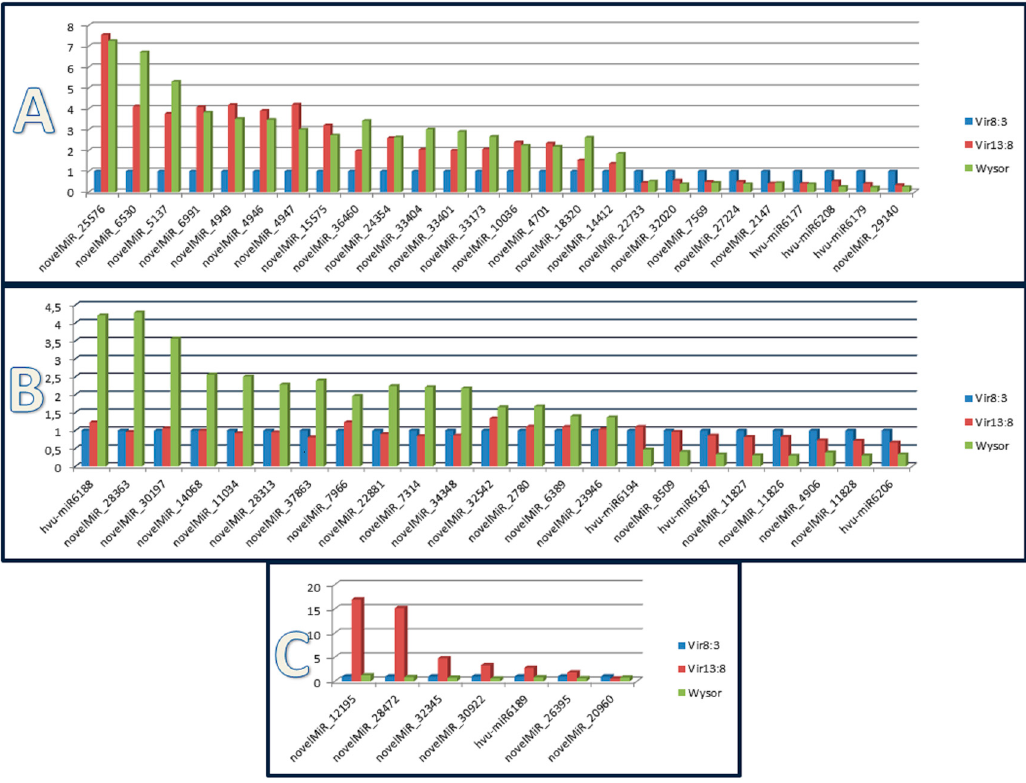
Figure 6. Expression of selected miRNAs as influenced by the barley genotype in response to BYDV infection. The miRNA expression in the BYDV infected group is shown. The average number of reads from the biological triplicates was used and transformed to normalized values such that a graphical comparison could be made. The values on the left axis are the fold-change values. In the top graph ( A ), miRNAs varying in their expression between Vir8:3 and the other two genotypes (Vir13:8 and Wysor) are displayed; in the middle graph ( B ), miRNAs varying in their expression between Wysor and the other two genotypes (Vir8:3 and Vir13:8) are displayed; and in the bottom graph ( C ), miRNAs varying in their expression between Vir13:8 and the other two genotypes (Vir8:3 and Wysor) are displayed.